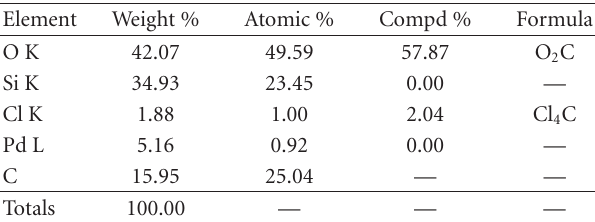
Table 1: EDX property and mass weight of proposed